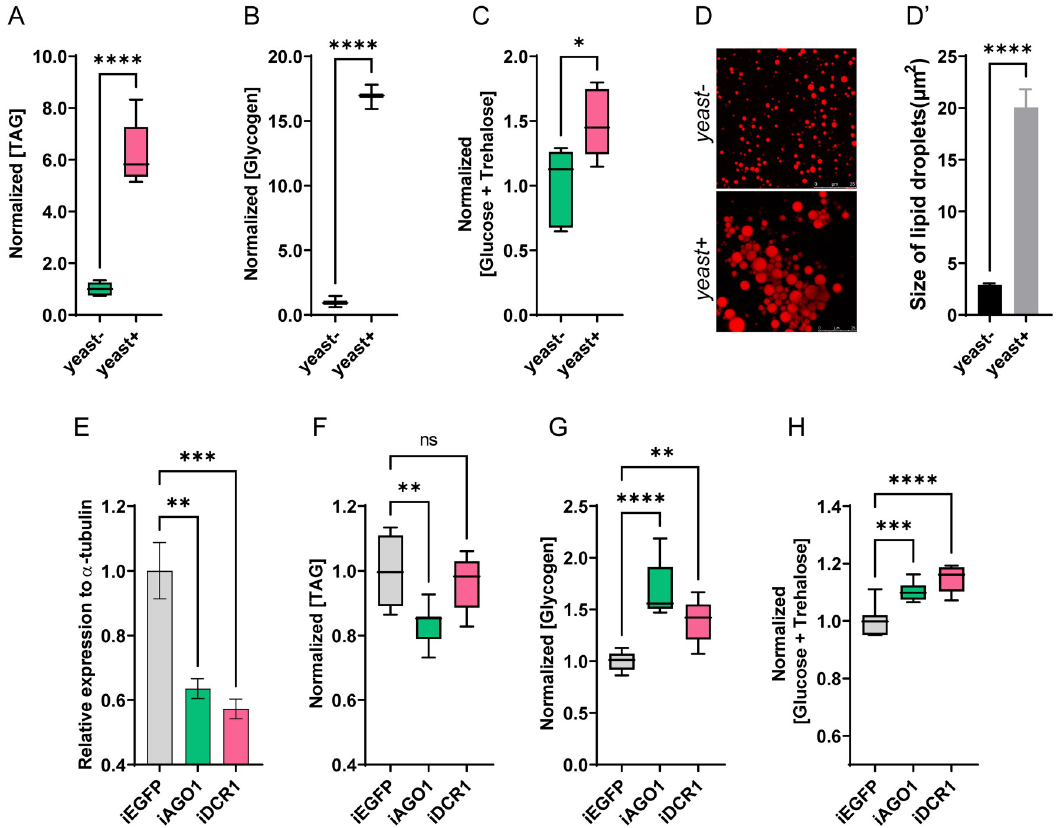
Fig 1. Dietary yeast may influence metabolic status via miRNA. The female of B . dorsalis were fed with or without dietary yeast for 4 days. Whole bodies of flies were homogenized in PBST solution, and then the contents of TAG (A), glycogen (B) or total sugar content (glucose plus trehalose) (C) were detected. The results were normalized to the total protein content. Boxplots show the data of seven independent biological replicates (n = 5 flies for each replicate). Asterisks indicate significant differences by Student’s t -test ( ���� , P < 0.0001; � , P < 0.05). (D-D’) Nile-red staining of the lipid droplets in the fat body of females. Pictures were obtained with a Leica SP8 confocal microscope (Scale bar: 20 μ m), and the lipid droplet size was quantified using ImageJ. “yeast-” and “yeast+” indicate the absence and presence of yeast in the diet, respectively. (E) RNAi efficiency of miRNA biosynthesis pathway-related genes AGO1 and DCR1 at 48 h post dsRNA microinjection. Data are expressed as means ± SEM of four independent replicates ( ��� , P < 0.001; �� , P < 0.01). (F-H) Effects of AGO1 and DCR1 RNAi on the metabolic content. (G) TAG content. (H) glycogen content. (I) total sugar content (glucose plus